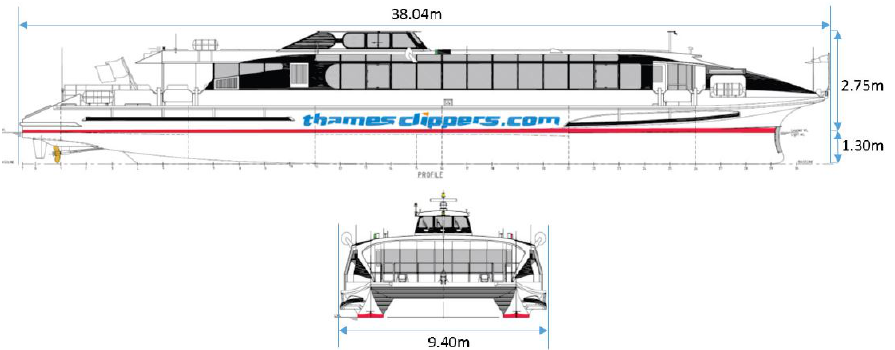
Figure 2. Cyclone clipper, drawings, and dimensions.